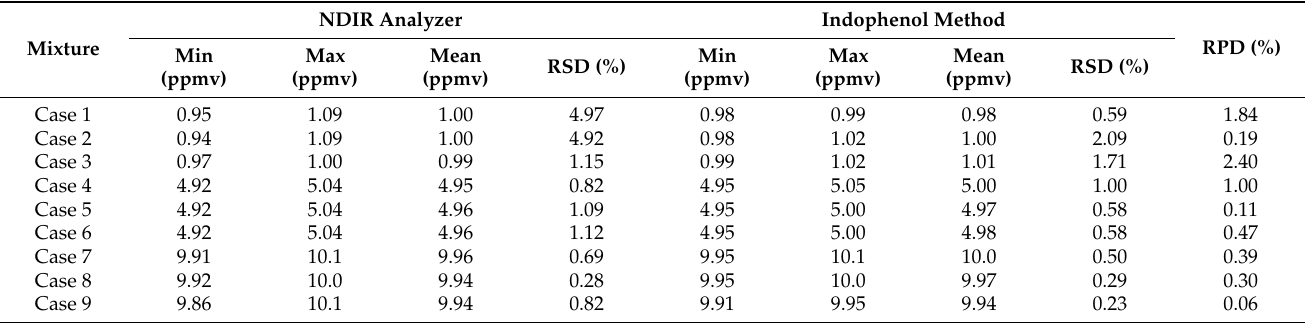
NDIR Analyzer Indophenol Method